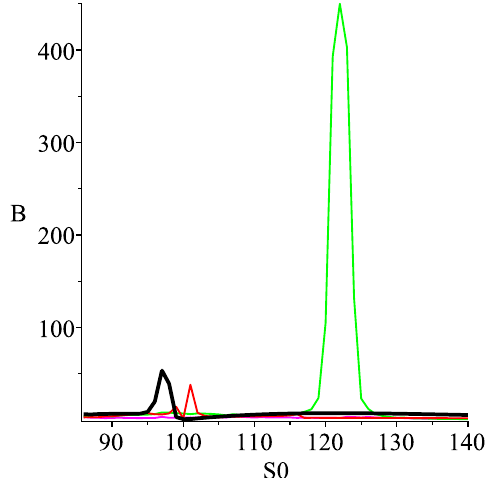
Figure 2. The value of B as a function of S 0 , for all the optimal models.